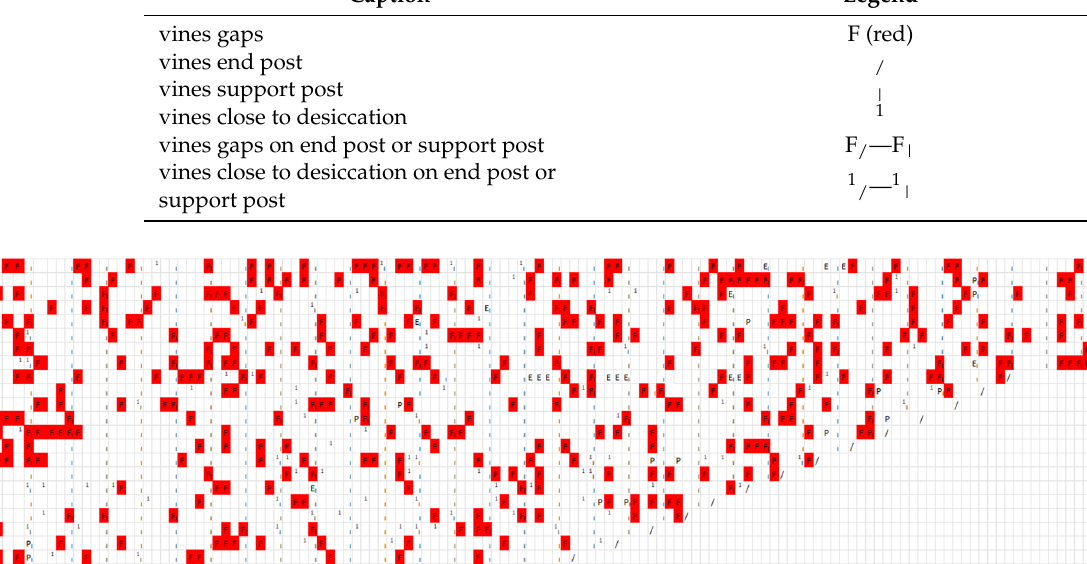
Figure 3. Vineyard mapping: each box responds to the ideal position of a grapevine, with different situations reported in Table 1. Mapping is crucial to choose two rows for LiDAR tests and two rows for standard tests with special features, such as gap distribution in the row and proper distance to avoid spray drift conditioning. Each couple of rows is divided into three blocks (Figure 4). The map is also used to identify plants and gaps of sample in which water-sensitive papers will be placed. The first guideline was to distinguish vine gaps and vine plants; in the former case, WSP were stapled on monofilament nylon screens; in the latter case, WSP were stapled directly on vine leaves. The second step relates WSP placement in the chosen samples: one paper in the lower position (thread position 1) and one paper in the upper